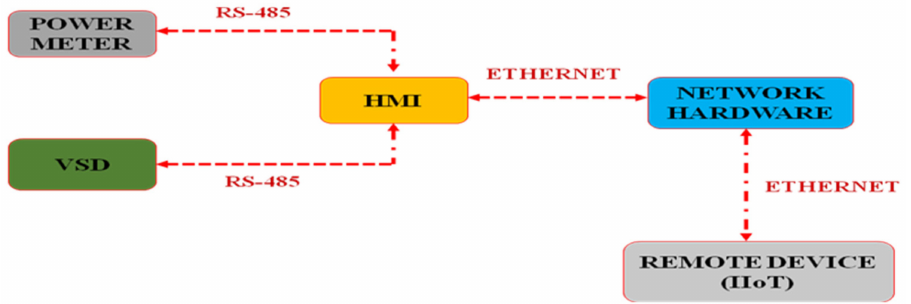
Figure 3. Architecture of the IIoT-based remote monitoring system.